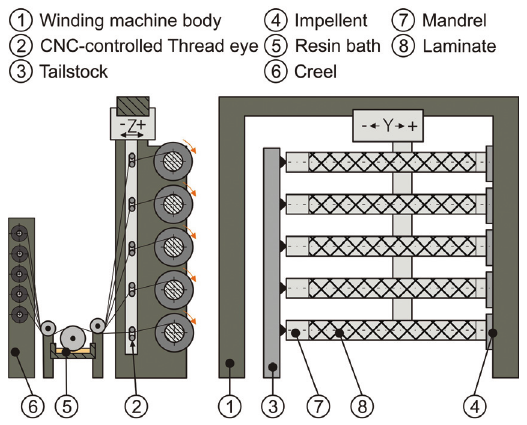
Figure 11 Schematic diagram of the assumed winding machine for cost calculation.